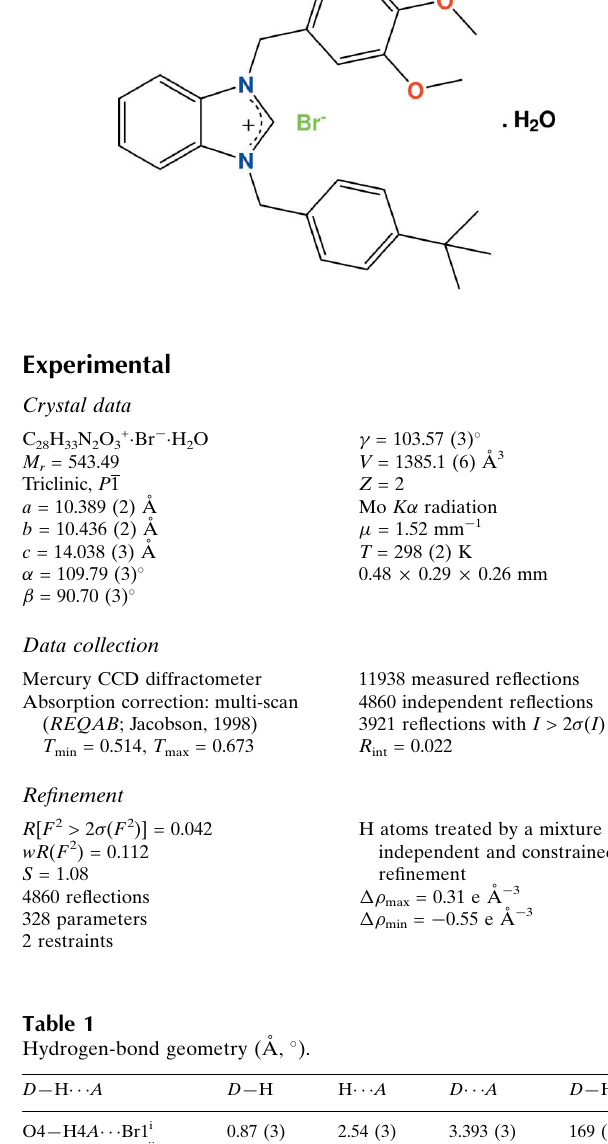
328 parameters 2 restraints